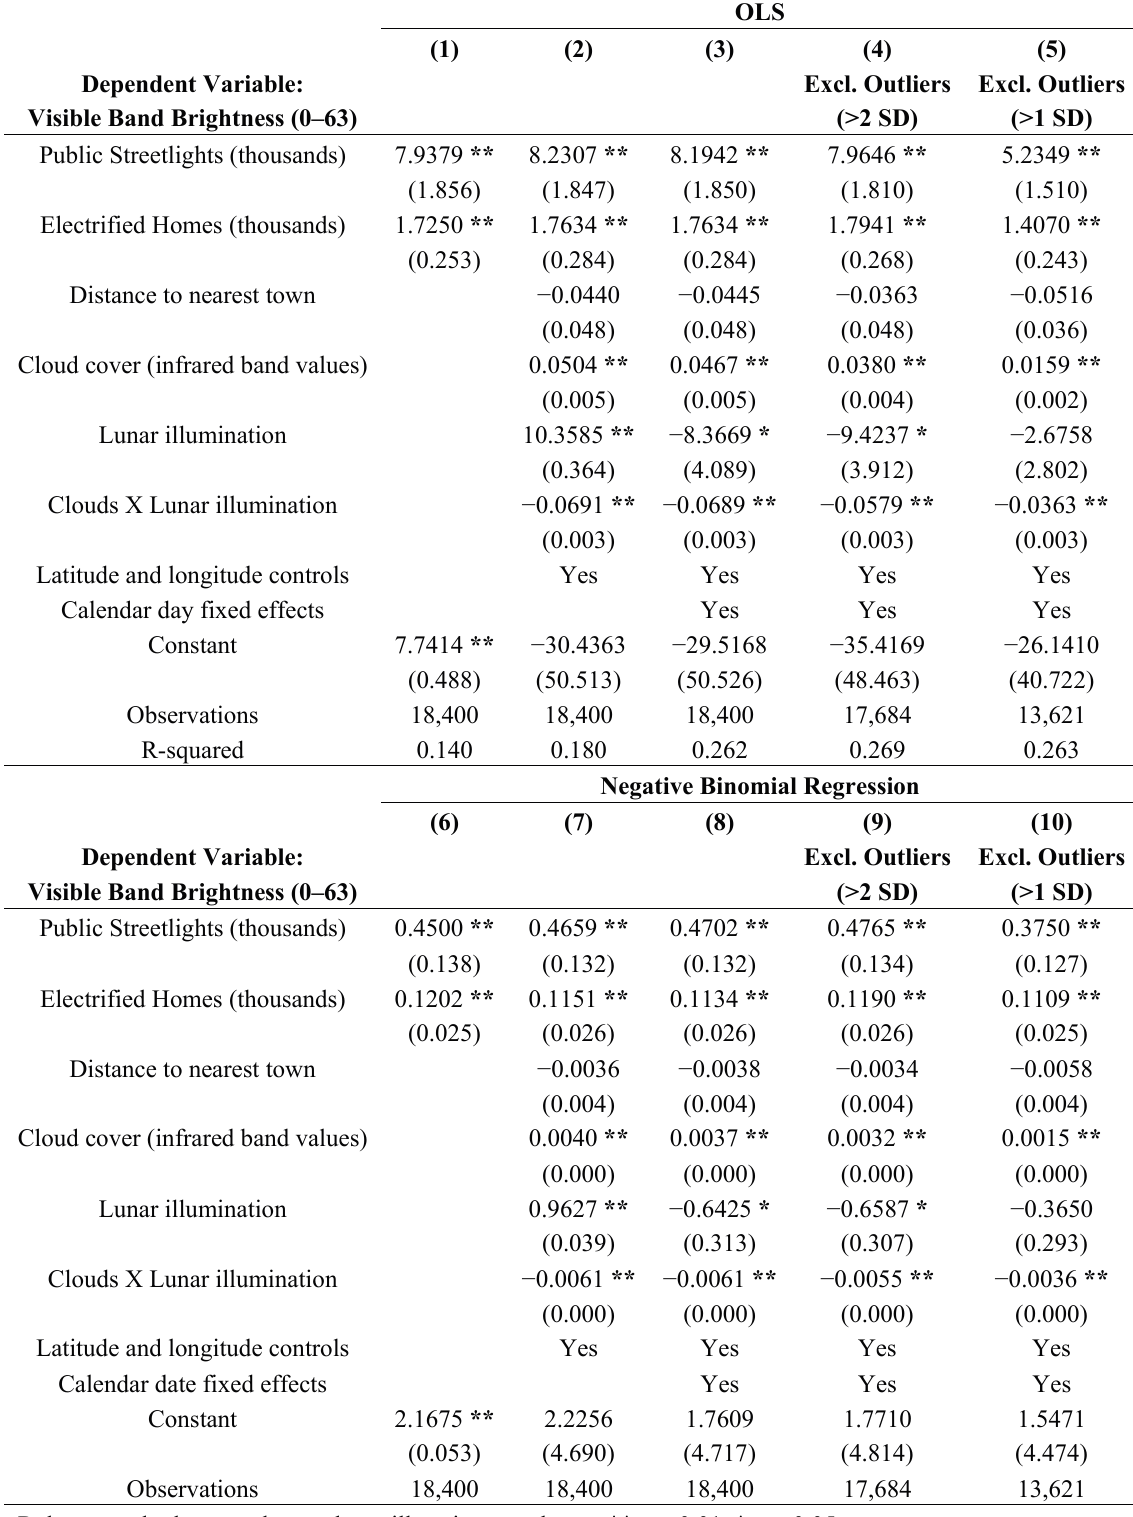
Table 4. Determinants of nightly DMSP-OLS light output. Data from 200